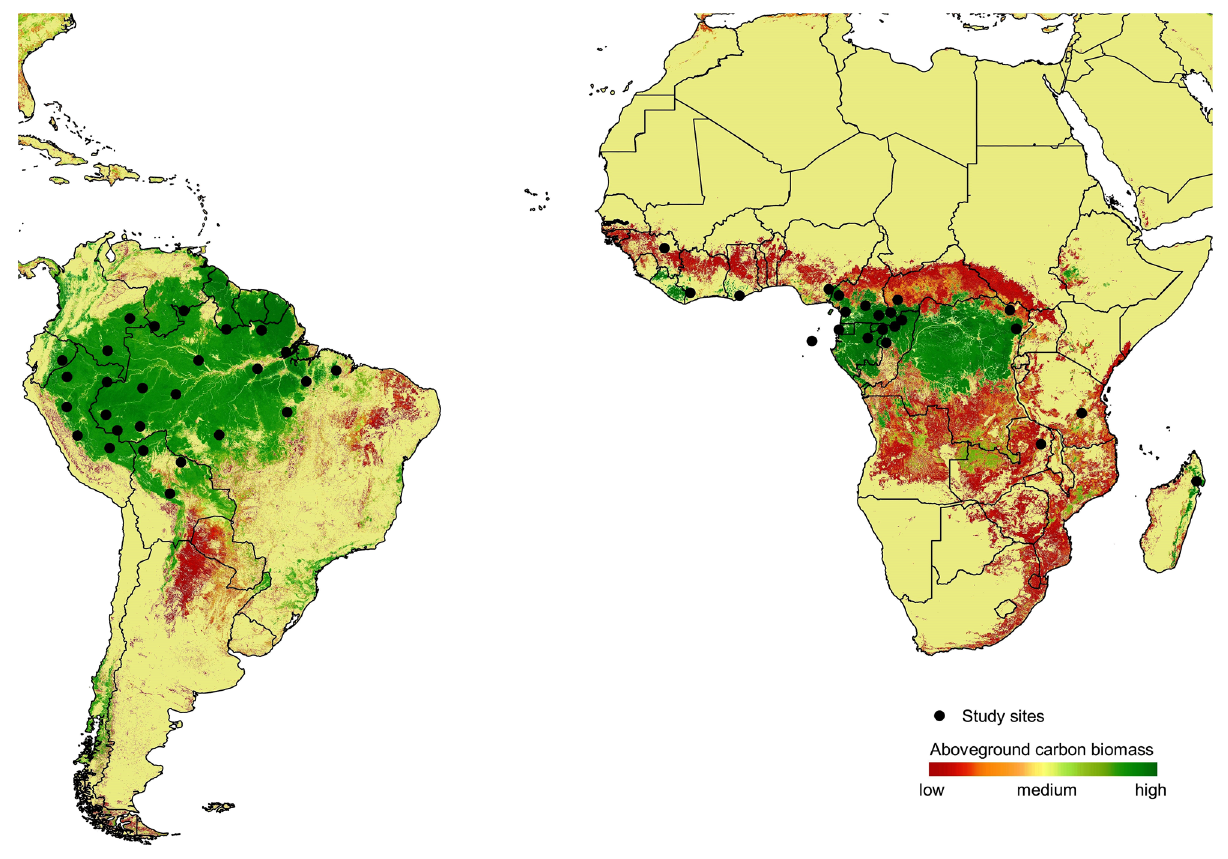
Figure 1. Geographic location of the 49 study sites compiled across seven South American and 14 African countries (including one site in Madagascar). The colour-coded background represents the distribution of above-ground forest biomass (range = 0–620 Mg ha −1 ) 84 . (Figure is created by QGIS 2.18.0, http:// qgis. osgeo.